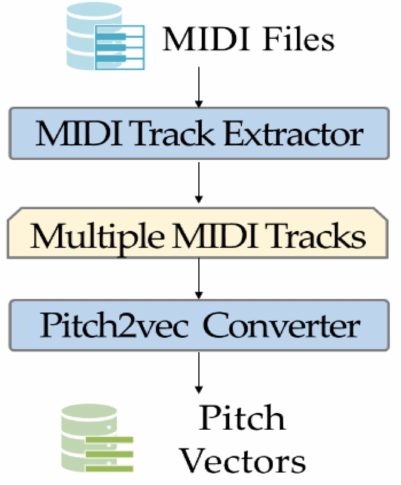
Figure 1. Pitch2vec preprocessing for the